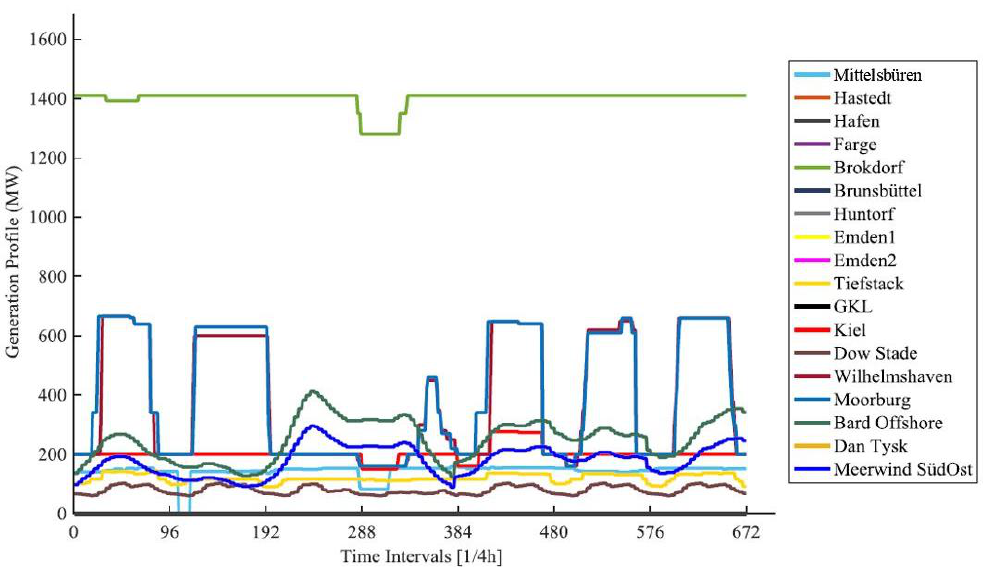
Figure 11. Weekly load and generation profile in the overall system ( top ) and in the distribution system ( bottom ).